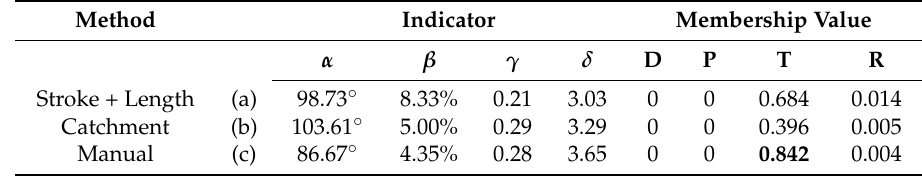
Table 7. Assessment result of generalized networks in Figure